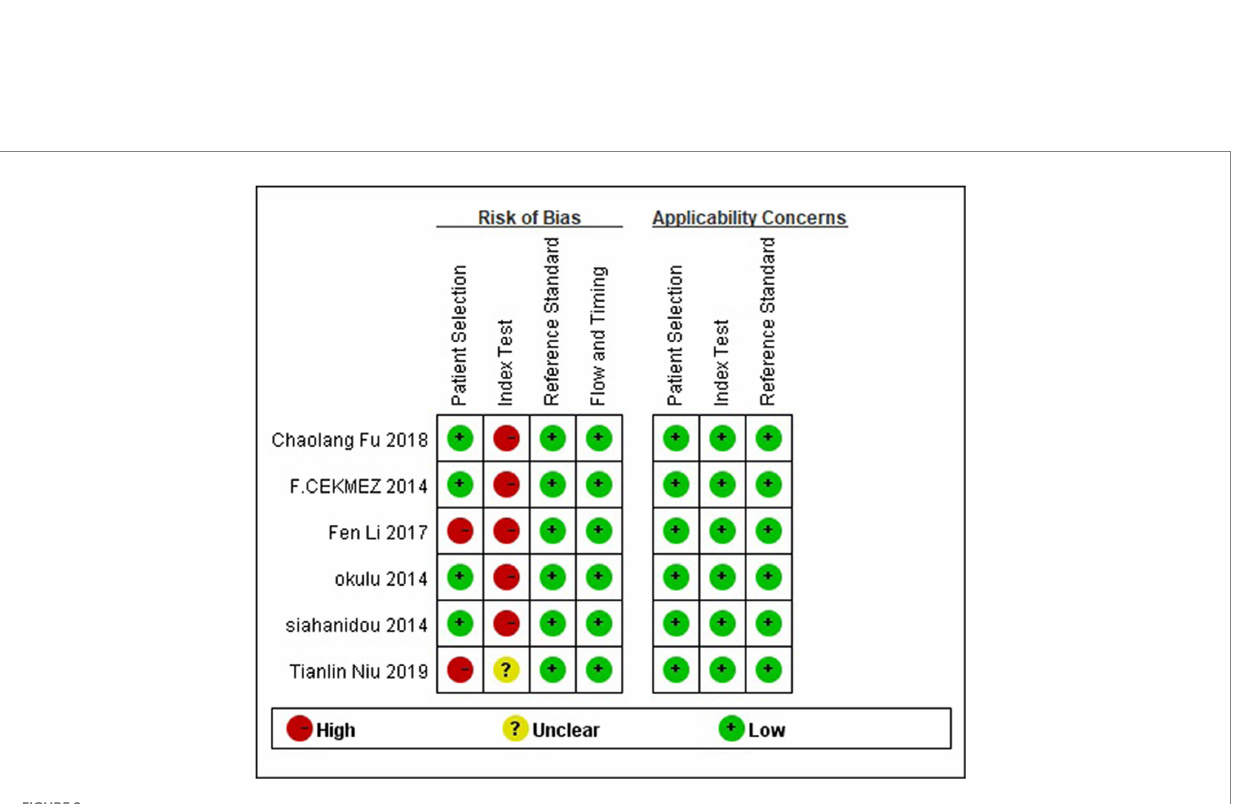
FIGURE 2 Quality assessment of diagnostic accuracy studies-2 (QUADAS-2)